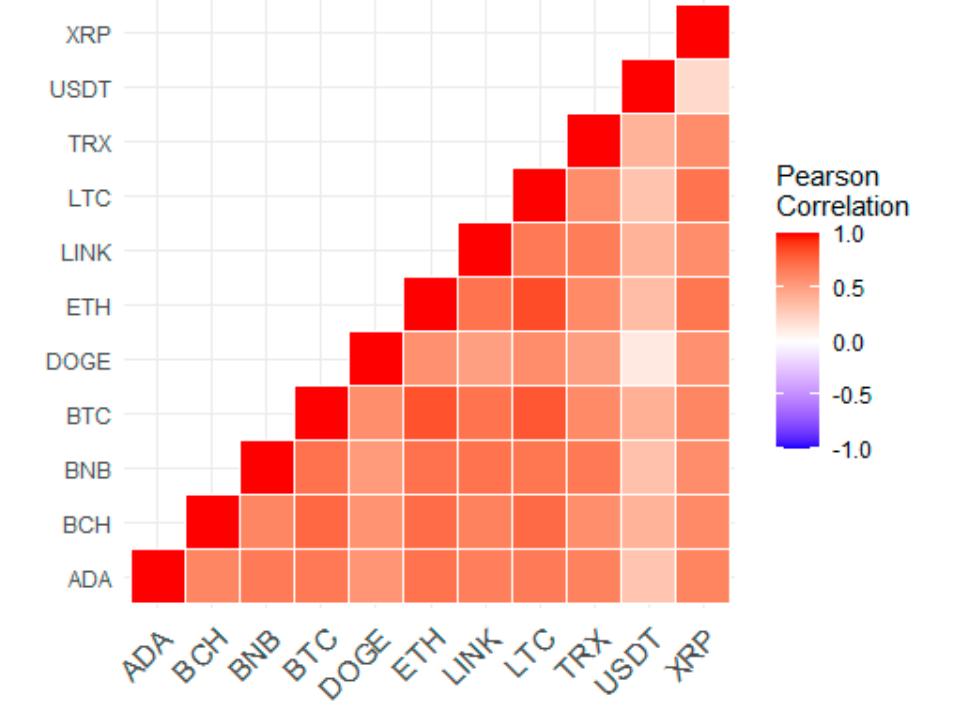
Figure 2. Correlation heat map. Table 1. Descriptive statistics of volatility